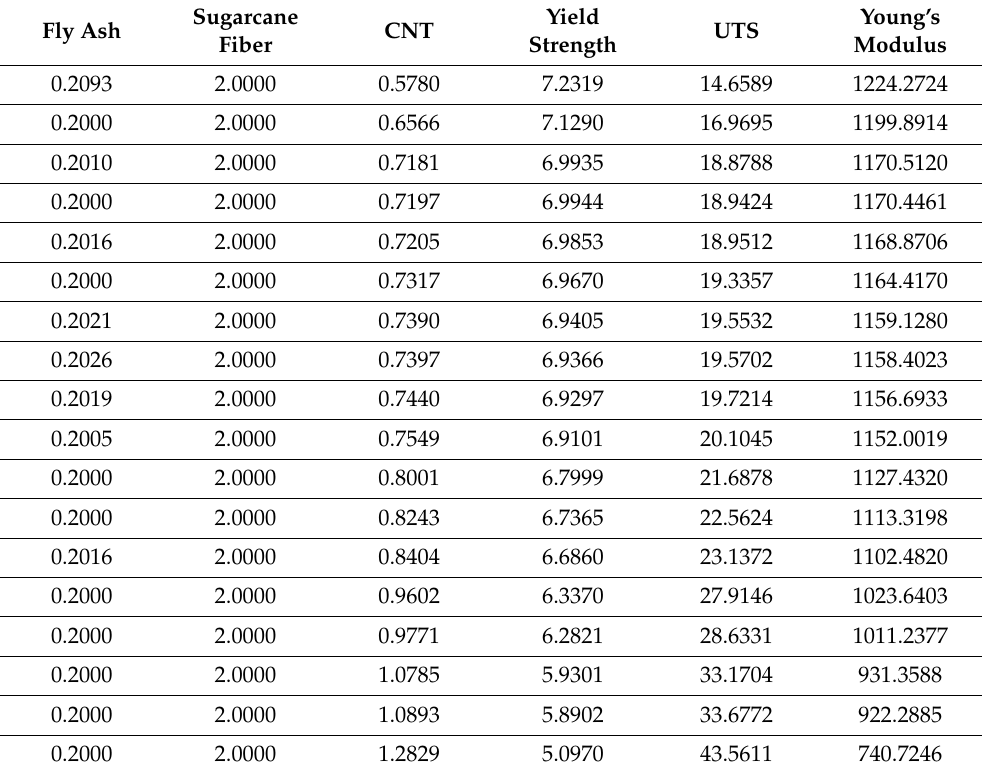
Table 3. Optimizing the objectives {YS, UTS, YM} with constraints imposed on input parameters {fly ash, SCF, CNT} ≥ 0.2. Yield Sugarcane CNT Fly Ash Strength Fiber